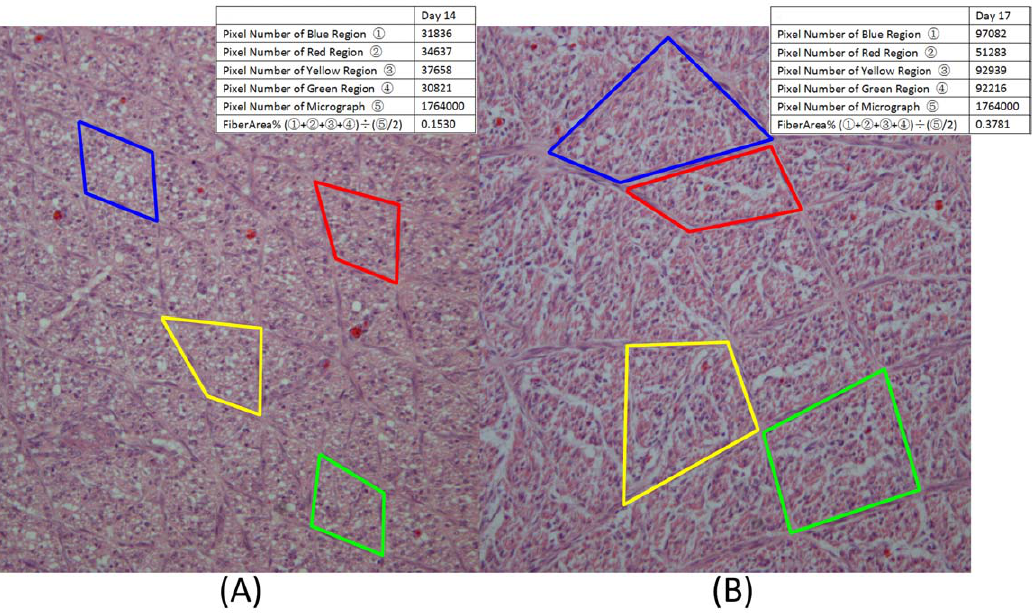
Figure 6. Depiction of the smooth muscle FiberArea% algorithm. Smooth muscle micrographs (200 6 magnification, 1260 6 1400 resolution) of embryonic gizzard at incubation day 14 ( A ) and incubation day 17 ( B ). Four muscle bundles are randomly chosen in each micrograph and the results of the FiberArea% algorithm are shown in right corner.